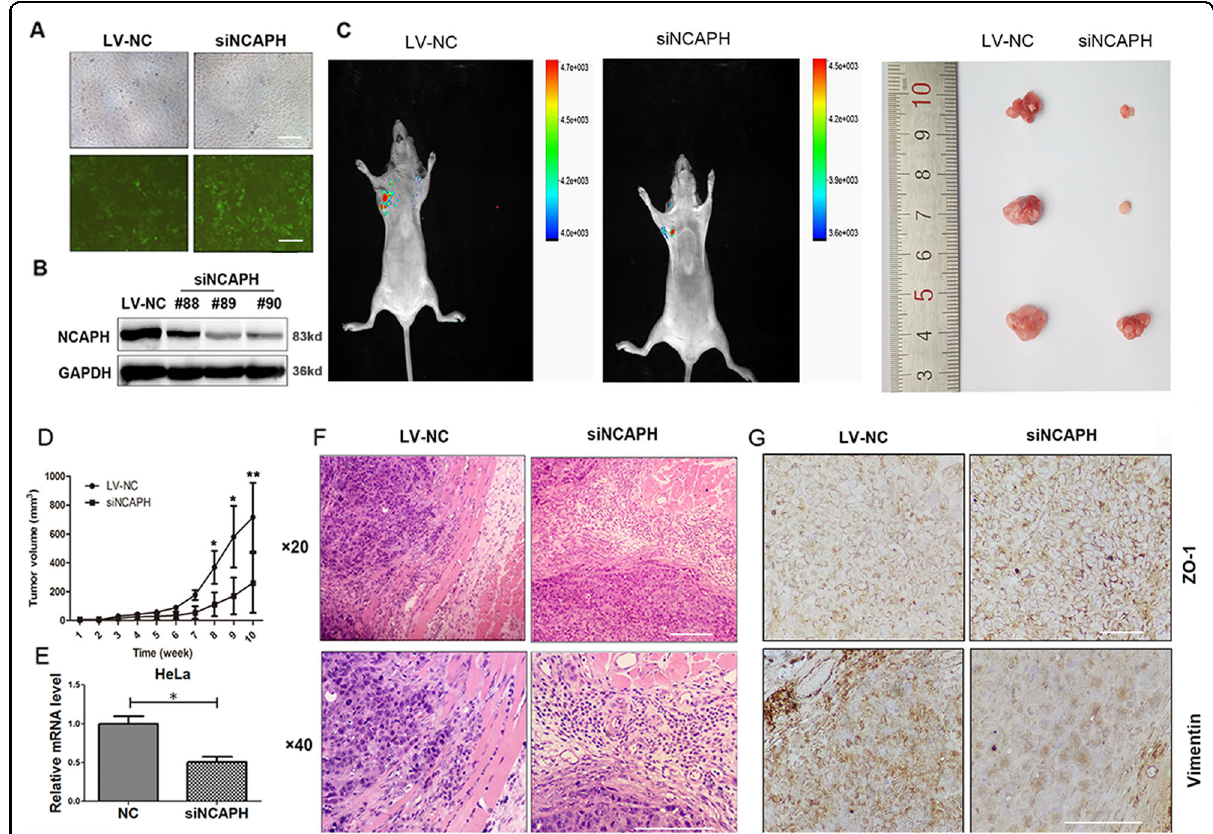
Fig. 4 Knockdown of NCAPH expression dramatically impaired the tumor growth, invasion and EMT process in nude mice. A Fluorescence microscopy of successful infection of HeLa cells with lentivirus containing pGV248-NCAPH shRNA (siNCAPH) and pGV248 control vector (LV-NC). Scale bars, 100 μ m. B Western blot analysis con fi rmed the knockdown of NCAPH in HeLa cells after 6-weeks of selection using puromycin. C , D The selected HeLa cells were injected into the axillary fossa of the mice. Ten weeks after injection, GFP expressing tumors were imaged in live mice. Then mice were humanely killed, and tumor volumes were calculated (six mice in each group). Representative images are shown. E The expression of NCAPH in tumors was determined by real-time PCR. F HE staining showed that tumors in the LV-NC group exhibited obvious muscle invasion, but those in the siNCAPH group were well-encapsulated. Scale bars, 100 μ m. G Immunohistochemical staining showed that ZO-1 protein signal was enhanced while vimentin was weakened after knockdown of NCAPH expression in mice tumors. Scale bars, 100 μ m. Data are presented as mean ± SD ( n = 3). * represents p < 0.05, ** represents p <